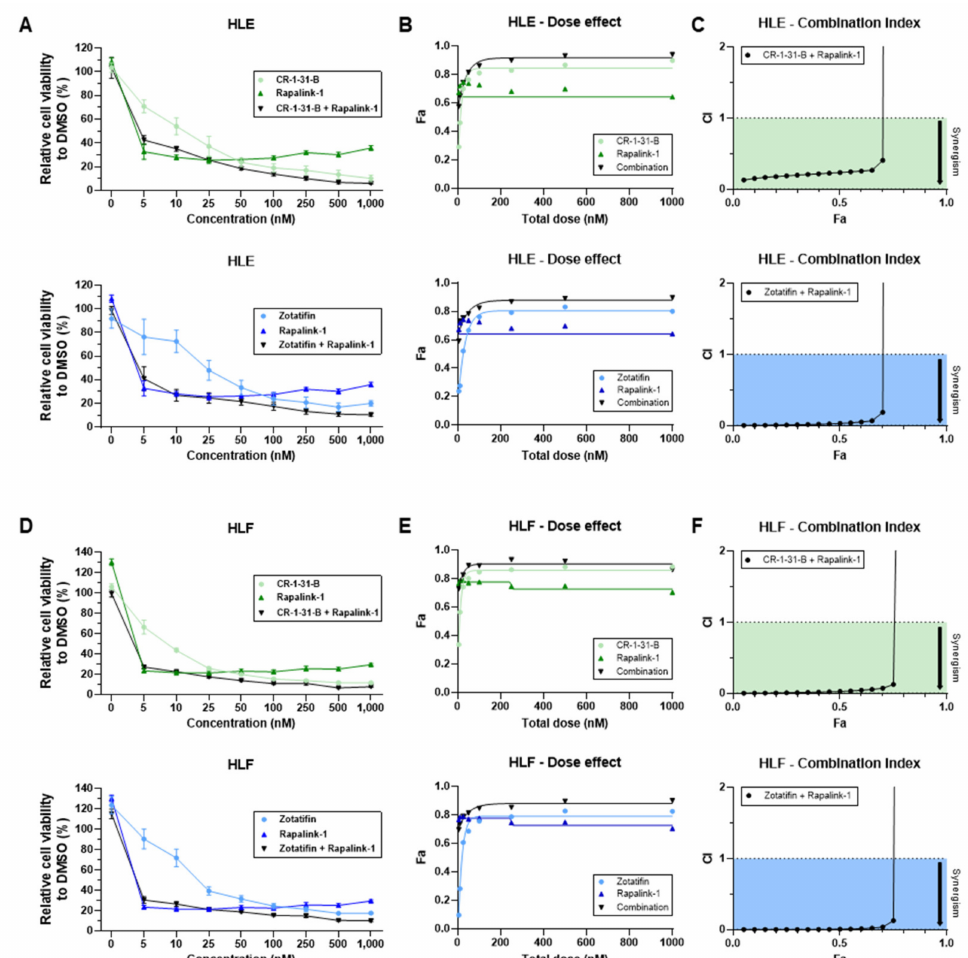
Figure 10. Highly synergistic cytotoxicity of combining the pan mTOR inhibitor, Rapalink-1, with CR-1-31-B and Zotatifin in hepatocarcinoma cell lines. ( A ) HLE and ( D ) HLF cells were exposed to various concentrations of compounds, alone or in combination, for 48 h. Cell proliferation based on the metabolic activity was assessed using the MTT assay and expressed as fold-change over DMSO control. The mean ± SEM of three independent experiments performed in technical triplicates are shown. ( B , E ) Dose effect curves of obtained fractions of dead cells (Fa) were used to determine the combination index (CI) ( C , F ) and synergism of drug combinations using CompuSyn software (https://www.combosyn.com, accessed on 1 November 2022) based on the Chou and Talalay method [50]. CI < 1 suggests